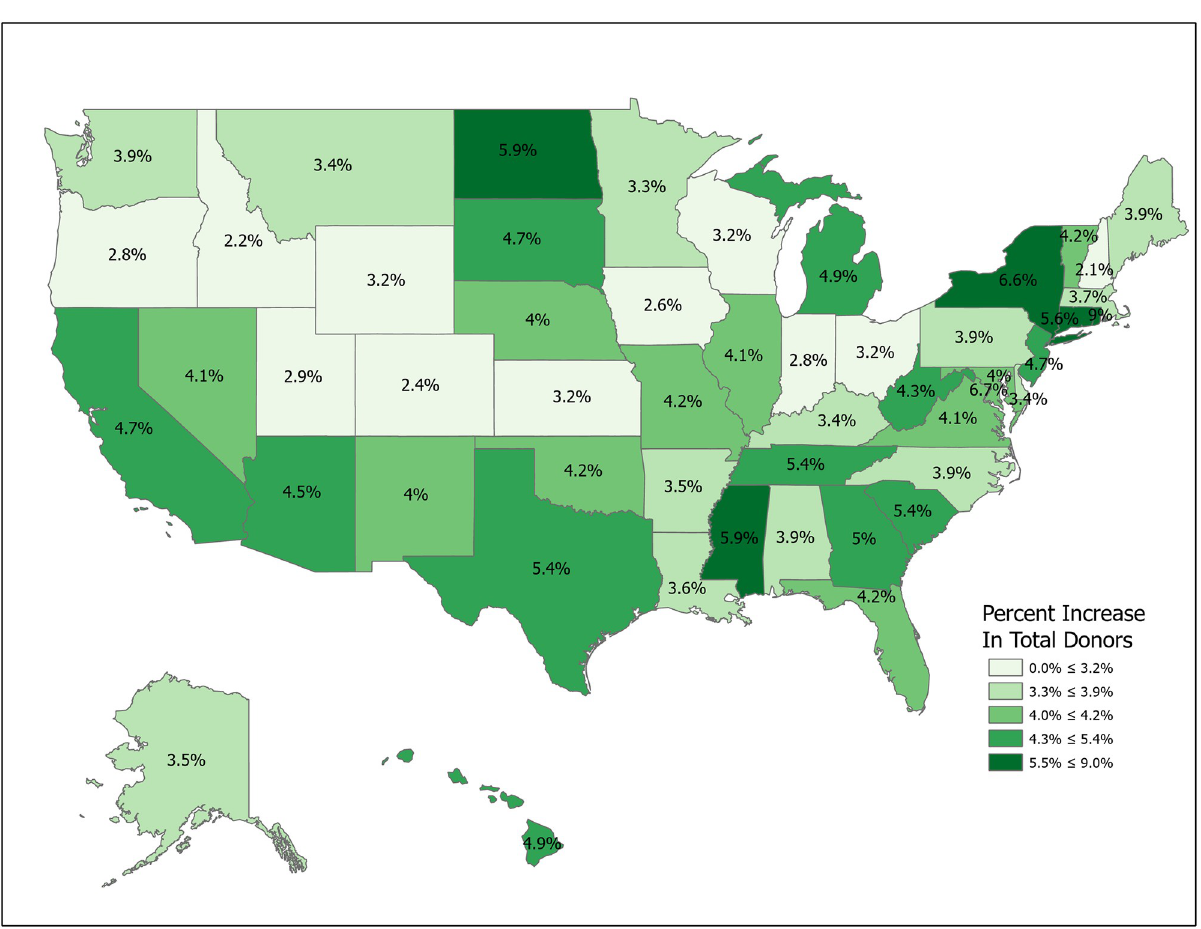
Fig 12. Simulation 6: Increase non-registered donor authorization rate ( q 2 ) by 5 percentage points. Maps created by ArcGIS Pro, URL: https:// www.esri.com/en-us/arcgis/products/arcgis-pro/overview. Base Map: World Light Gray Base, URL: https://services.arcgisonline.com/arcgis/rest/